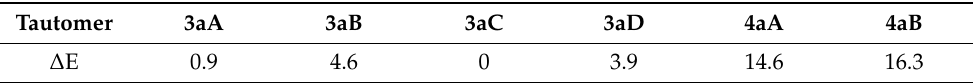
Table 1. Predicted relative energies (kcal/mol) of possible isomers of benzofuroxan and aminothia- zole hybrids.